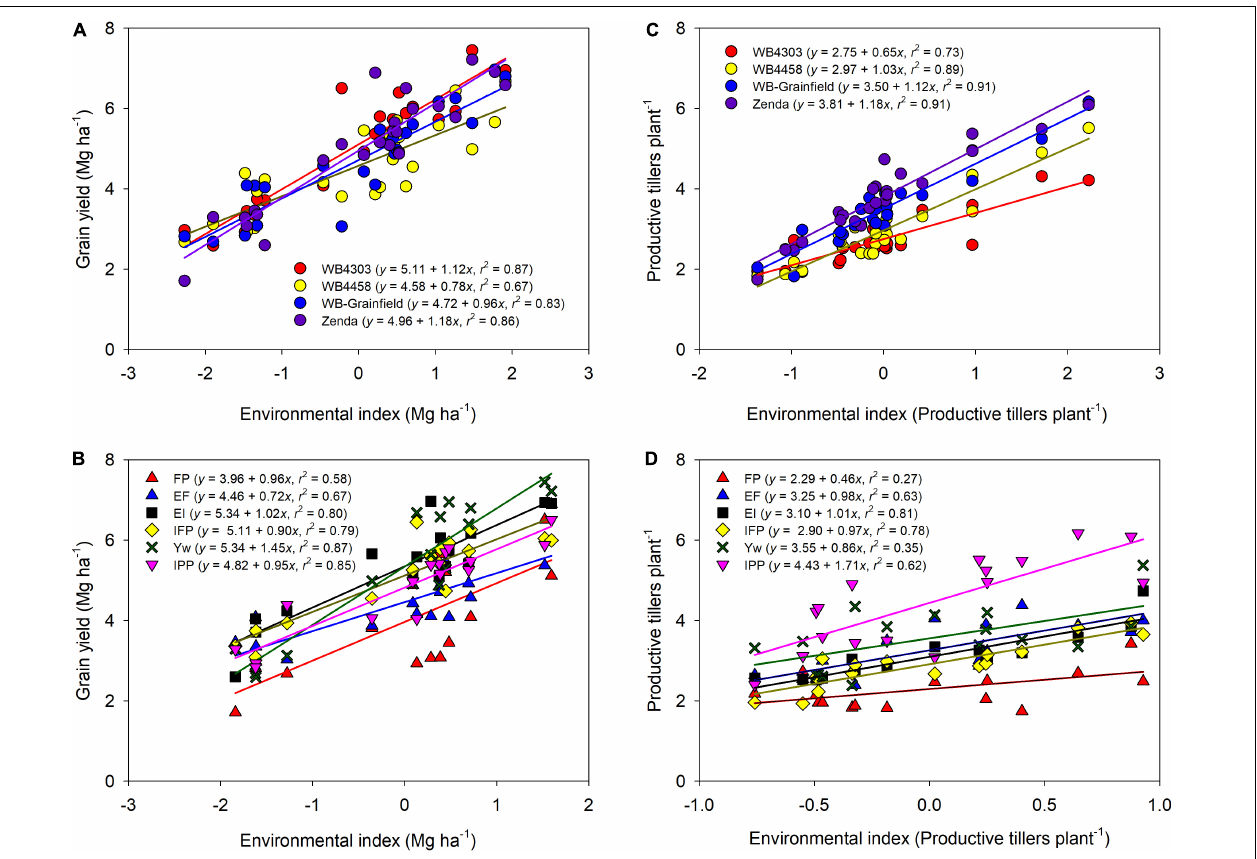
FIGURE 2 | Wheat grain yield (A,B) and productive tillers per plant (C,D) as affected by the environment index for each wheat genotype (WB4303, WB4458, WB-Grainfield, and Zenda) (A,C) and management intensity (FP, farmer practice; EF, enhanced fertility; EI, ecological intensification; IFP, increased foliar protection, Yw, water-limited yield potential; and IPP, increased plant productivity) (B,D). Environmental indices were calculated as the combination of environment (Bel18, Hut18, Bel19, and Hut19) and (A,C) management practices or (B,D)